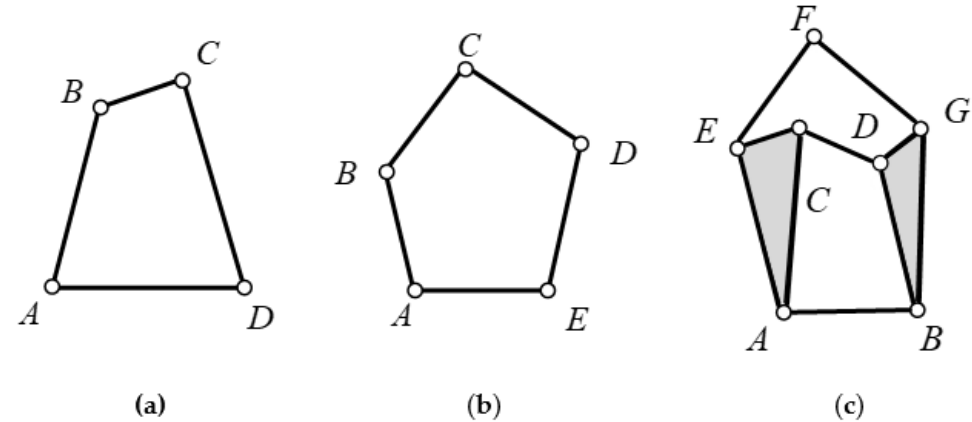
Figure 7. Common mechanism of multi-rod mechanism in prosthesis. ( a ) 4-bar mechanism, ( b ) 5-bar mechanism, ( c ) 6-bar mechanism.